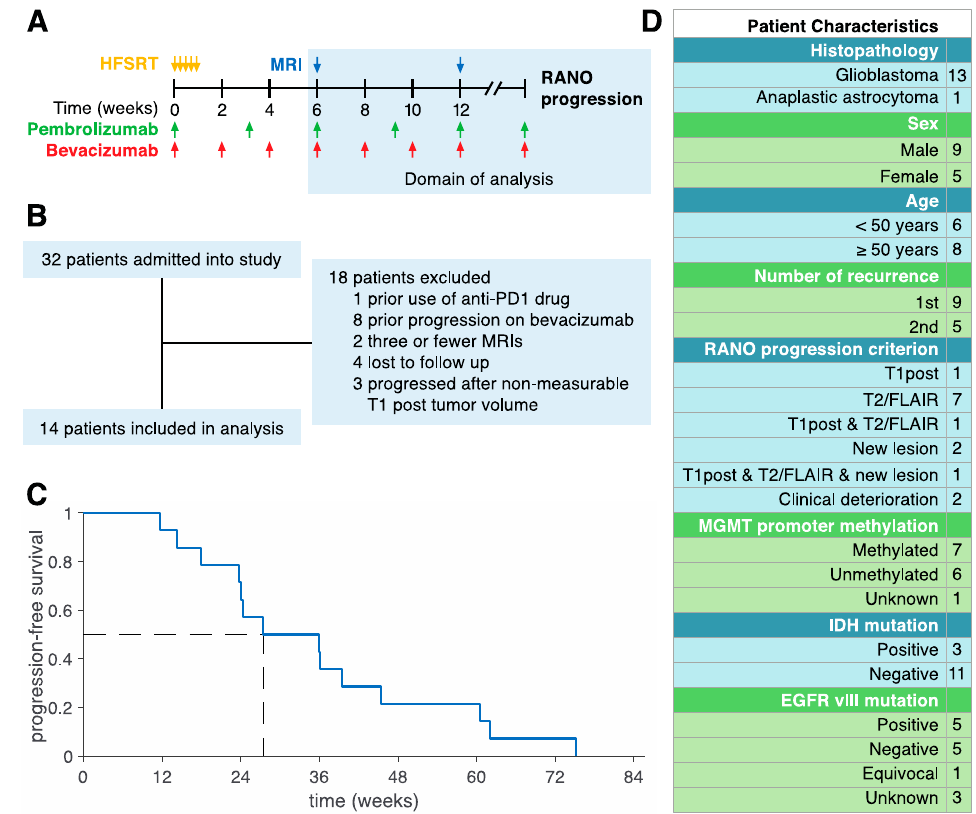
Figure 1. Patient Cohort. ( A ) Schematic of the NCT02313272 protocol. Patients were treated with hypo-fractionated stereotactic radiotherapy (HFSRT; 6 Gy × 5) plus pembrolizumab (100 or 200 mg, every 3 weeks) and bevacizumab (10 mg / kg, every 2 weeks). MRIs were taken approximately every 6 weeks. The shaded region indicates the time domain of the present analysis. ( B ) Exclusion criteria. A total of 32 patients were enrolled into the clinical trial with 14 patients included in the present analysis. ( C ) Progression-free survival for the 14 patients included in the present analysis. The median time to progression was 27.4 weeks. ( D ) Characteristics of 14 patients included in the study.